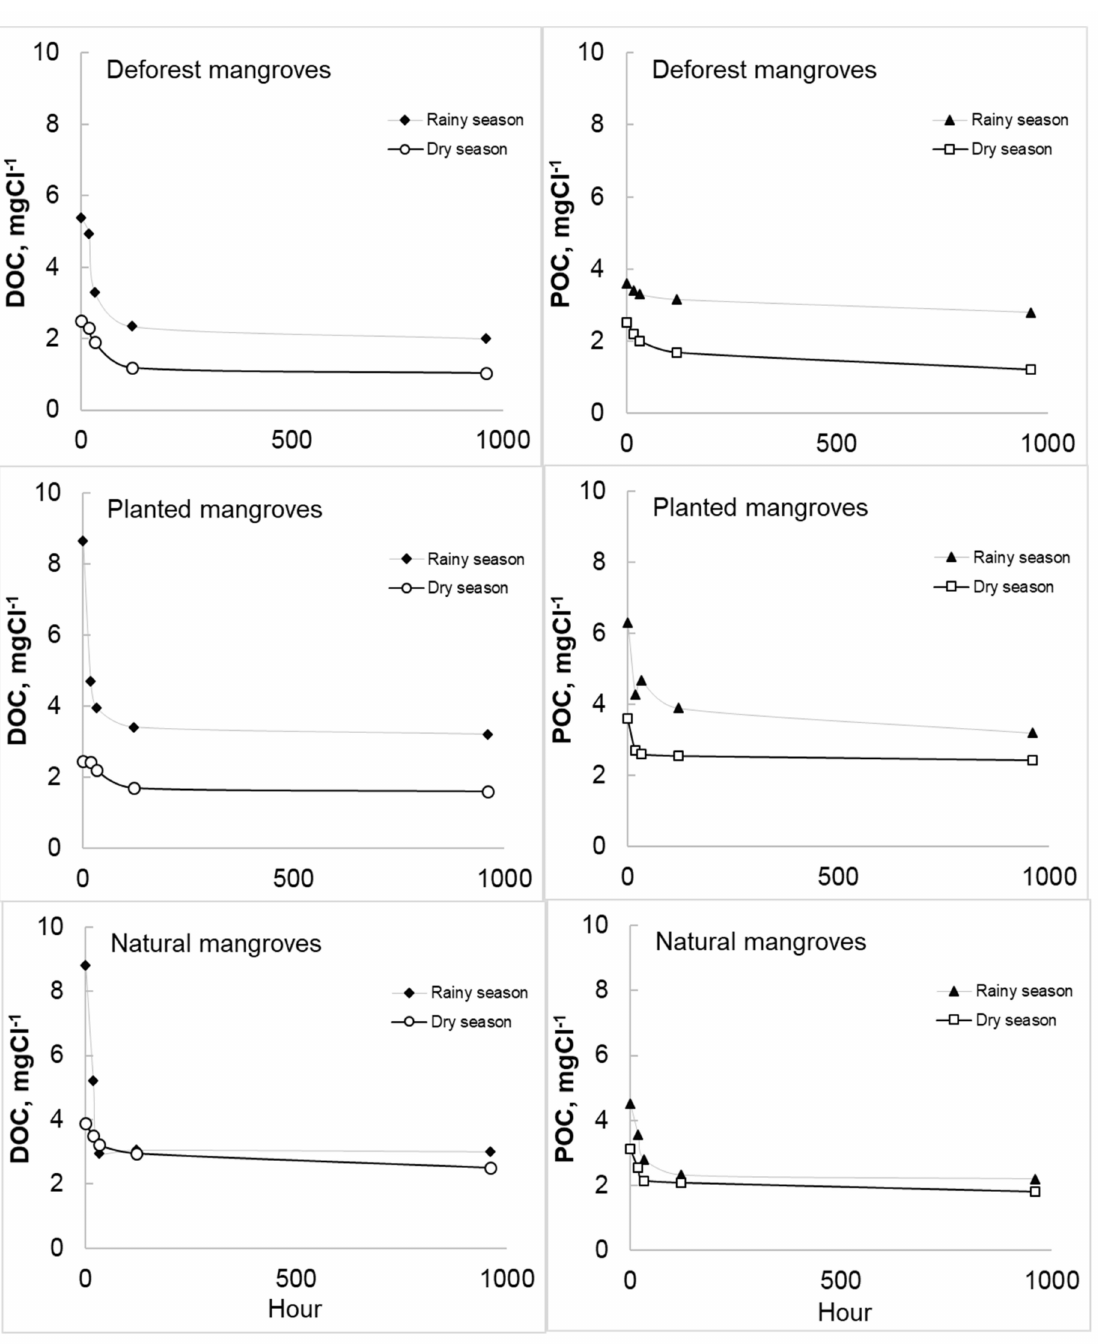
Figure 3. Degradation of DOC (black symbol) and POC (white symbol) (mgCL − 1 ), in dry season and rainy season (January and July, respectively) at different sampling